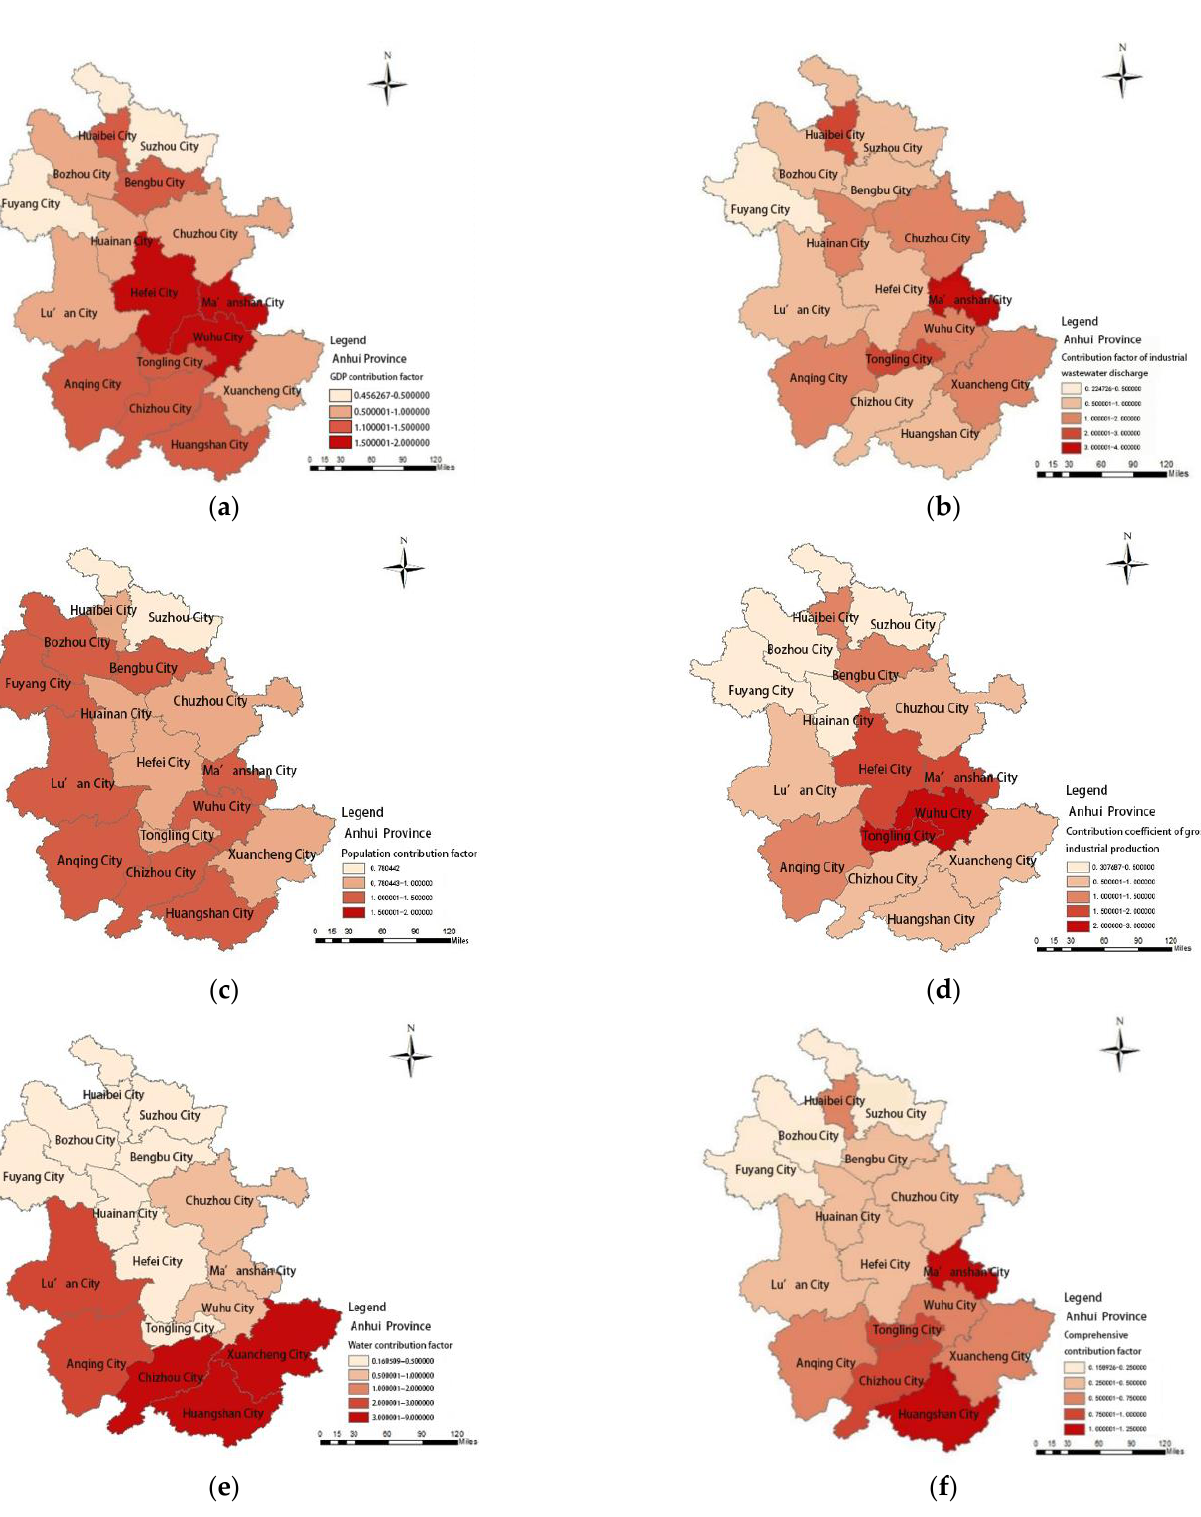
Figure 8. Distribution of COD index contribution coefficient in the benchmark year of Anhui Province. ( a ) GDP contribution factor. ( b ) Contribution factor of industrial wastewater discharge. ( c ) Population contribution factor. ( d ) Contribution factor of gross industrial production. ( e ) Total water contribution factor. ( f ) Comprehensive contribution factor.